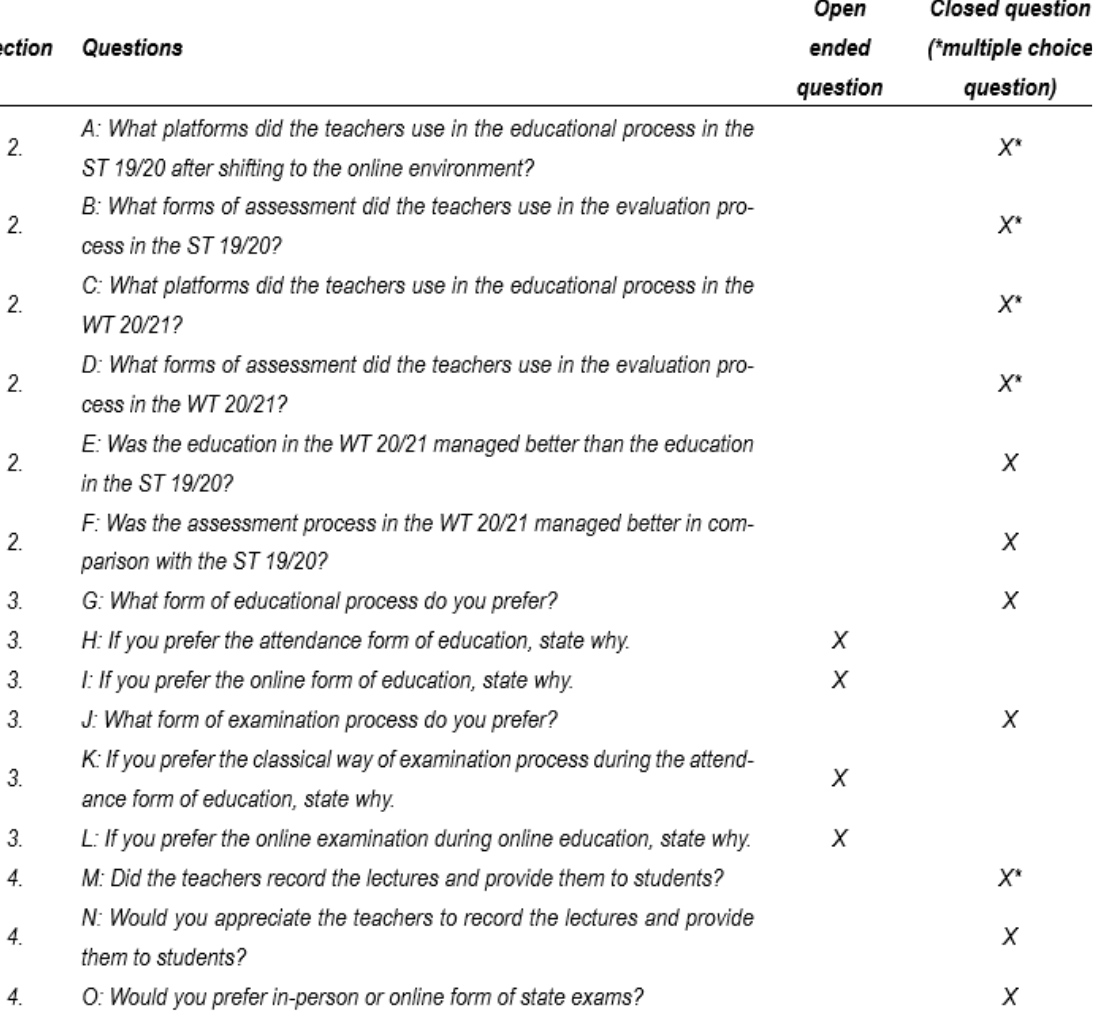
Questions in the Second, Third and Fourth Section in the Students’